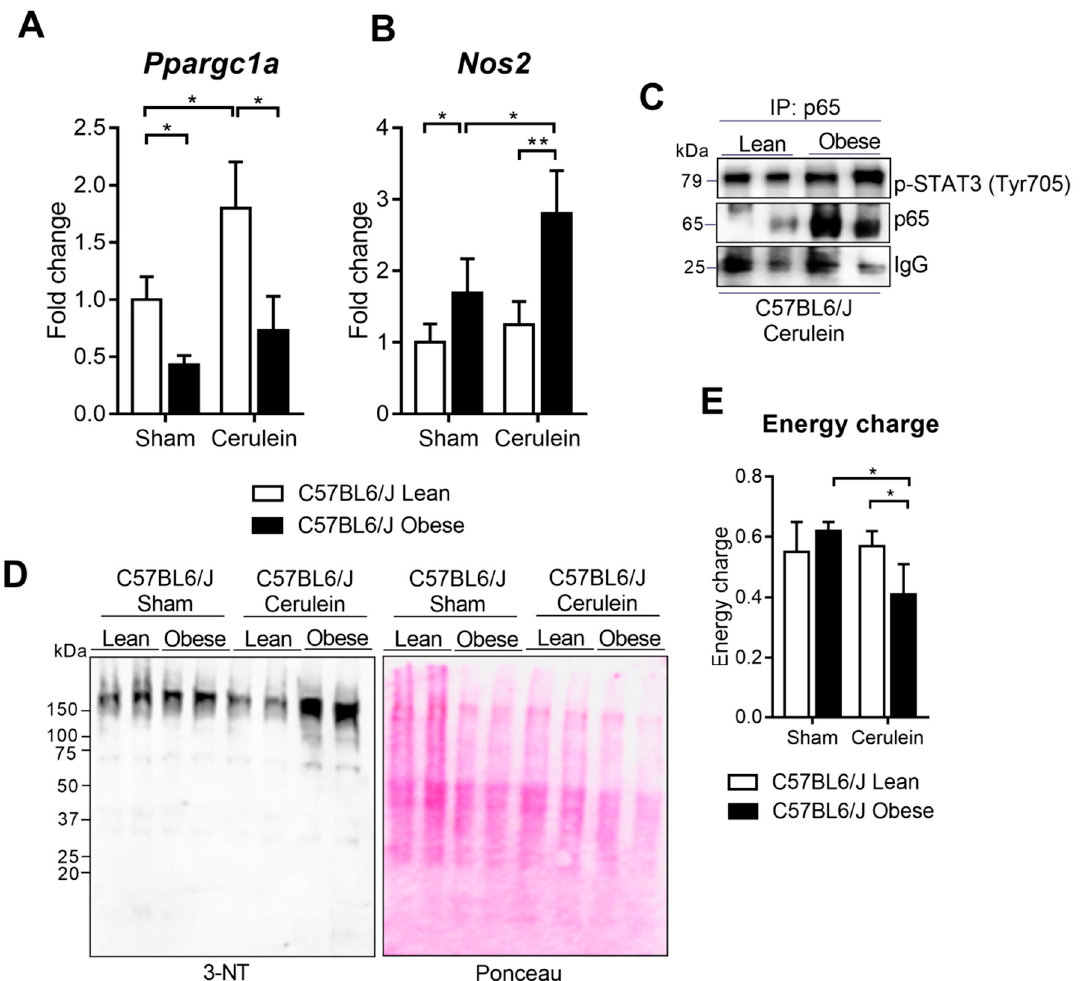
Figure 6. ( A ) mRNA relative expression of Ppargc1a versus Tbp (TATA-binding protein; housekeeping) in the livers of the sham lean and obese mice and 1 h after cerulein-induced acute pancreatitis (Cerulein). ( B ) mRNA relative expression of Nos2 versus Tbp in the livers of the sham lean and obese mice and 1 h after cerulein-induced acute pancreatitis (Cerulein). ( C ) Representative Western blot of p-STAT3 (Tyr705) and p65 in p65 immunoprecipitate of the sham lean and obese mice and 1 h after cerulein-induced acute pancreatitis (Cerulein). IgG was used as the loading control. ( D ) Representative Western blot of 3-NT in the livers of the sham lean and obese mice and 1 h after cerulein-induced acute pancreatitis (Cerulein). Ponceau was used as the loading control. ( E ) Energy charge in the livers of the sham lean and obese mice and 1 h after cerulein-induced acute pancreatitis (Cerulein). There were five mice per group. Statistical difference is indicated as * p < 0.05 and ** p < 0.001.